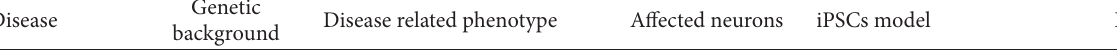
Table 1: Neurological disorders modeled with patient-specific human induced pluripotent stem